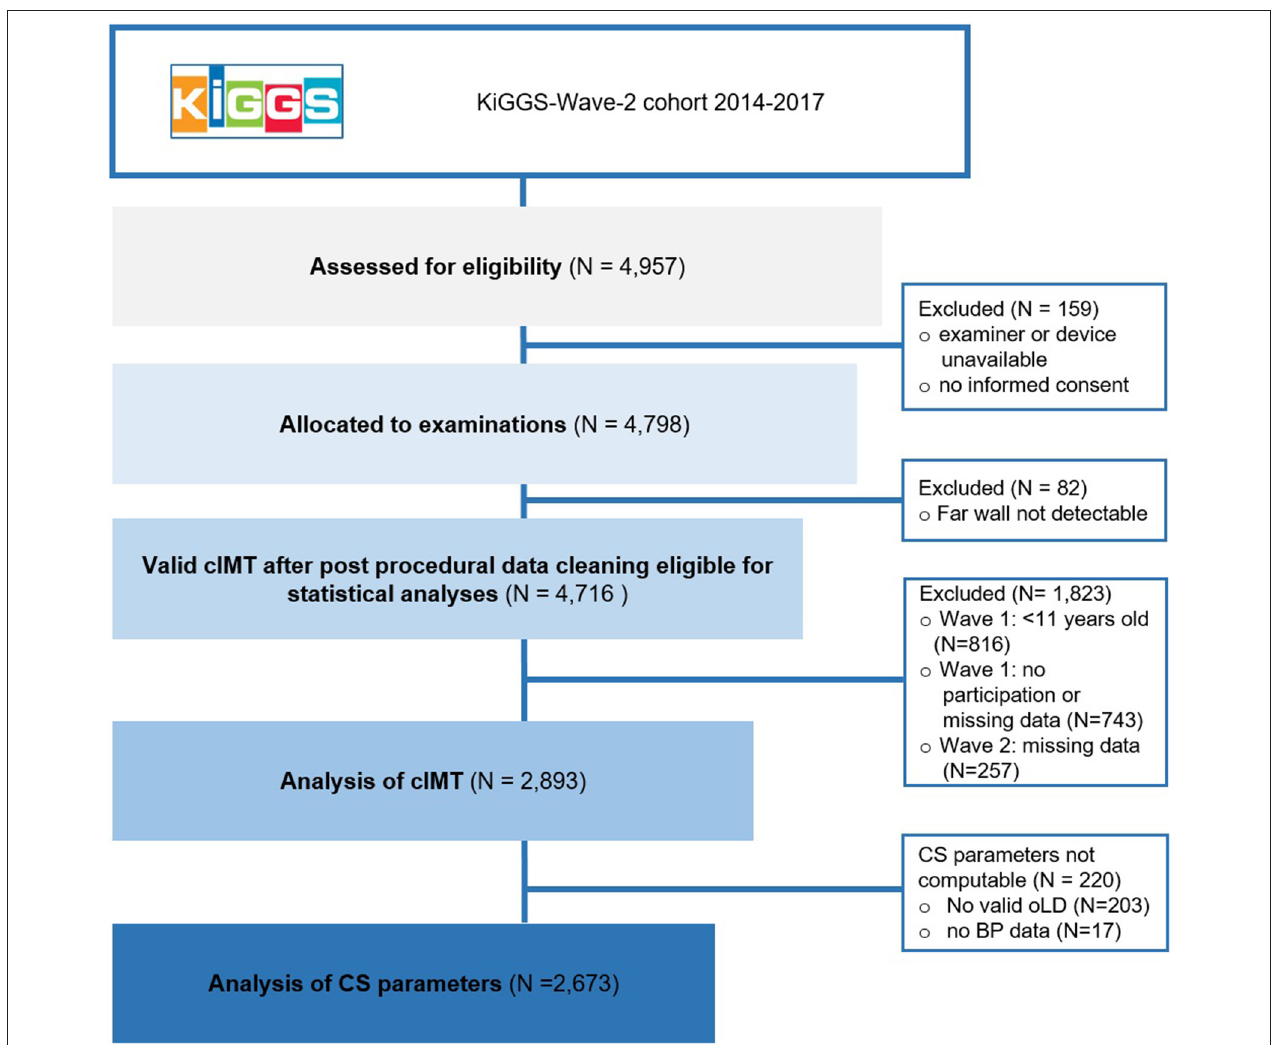
FIGURE 1 | Flow-chart of data collection and cleaning ( n